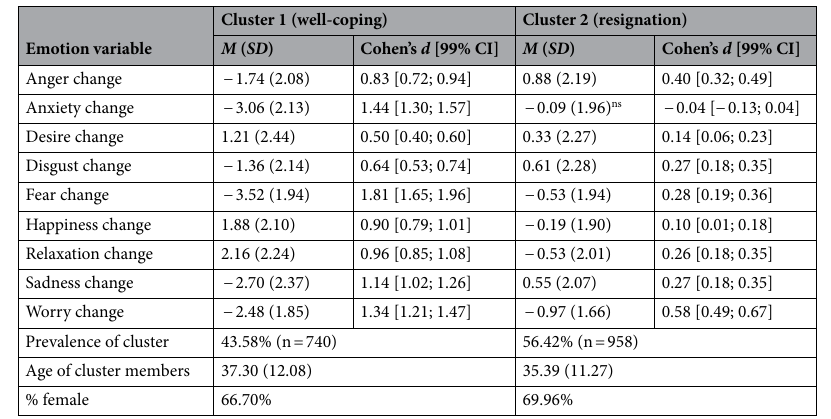
Table 3. Cluster means (SD) and effect sizes for difference from zero after k -means clustering with the final model of k = 2. Negative change values indicate that the value of the emotion went down in phase 2 compared to phase 1. Vice versa for positive values. Values of zero imply no change. ns = not significantly different from 0 at p < 0.01.